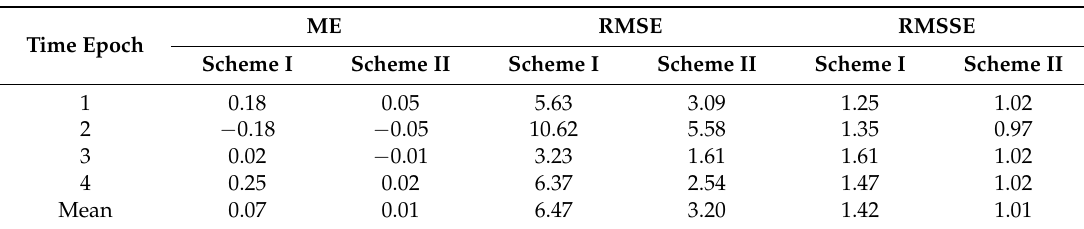
Table 6. Prediction accuracies of CK in terms of ME, RMSE, and RMSSE resulting from the two schemes and the selected time epoch (unit: